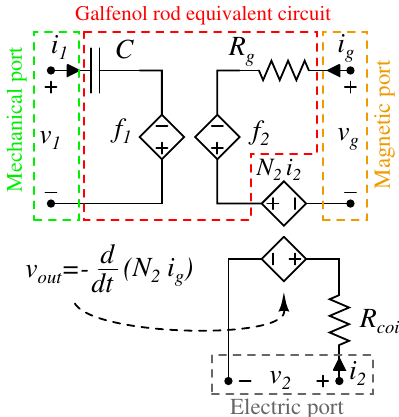
Figure 5. Equivalent three-port nonlinear model circuit of a Galfenol rod. In the first port, voltages and currents correspond to forces and velocities, respectively, while in the second port are magnetic voltages and flux. Furthermore, voltages and currents of the third port correspond to real quantities delivered to the load. The nonlinear functions are: f 1 = l g ξ · g ( v 1 , v g